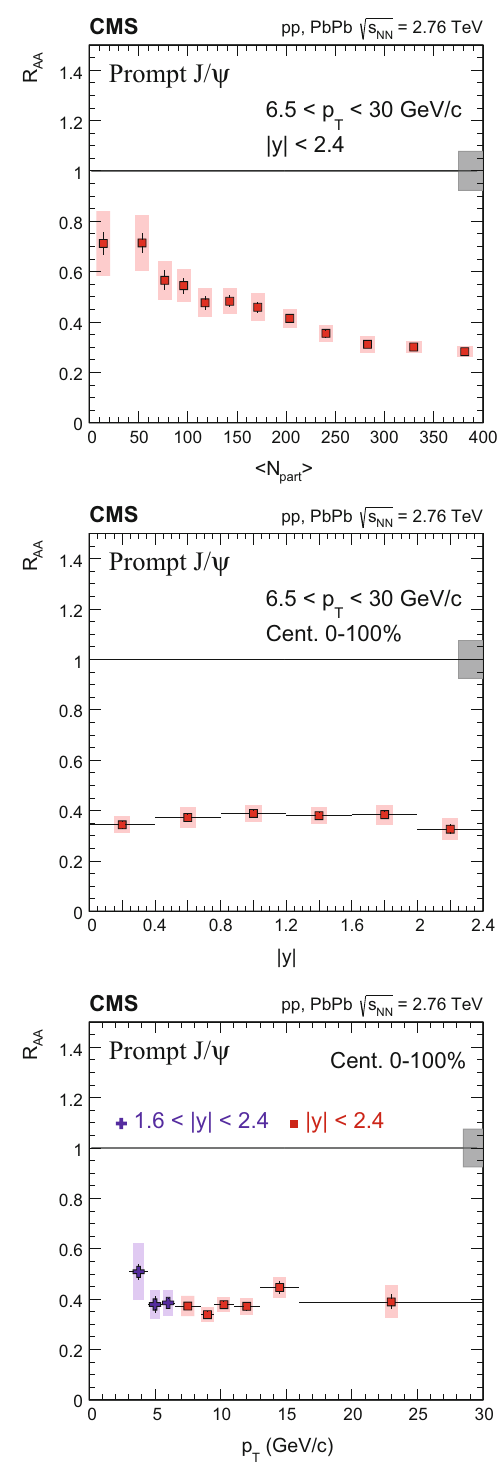
Fig. 3 Prompt J /ψ v 2 as a function of centrality ( top ), rapidity ( mid- dle ),and p T ( bottom ).The bars ( boxes )representstatistical(systematic) point-by-point uncertainties. The global uncertainty, listed in the leg- end, is not included in the point-by-point uncertainties. Horizontal bars indicate the bin width. The average N part values correspond to events flatly distributed across centrality